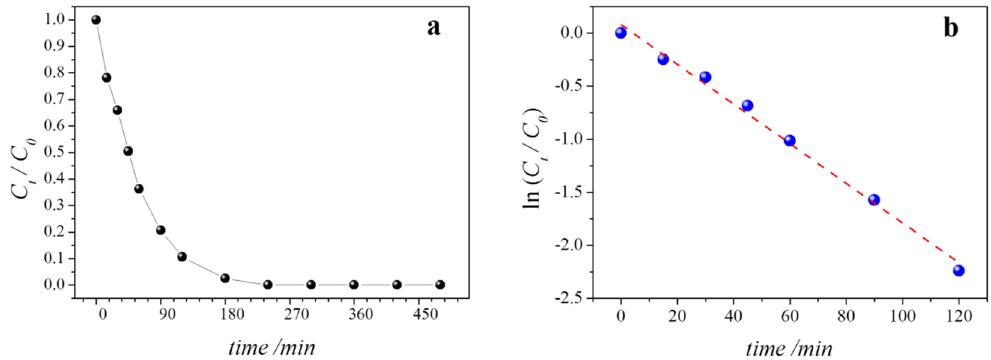
Figure 5. ( a ) Relative concentration decay of 4-nitrophenol determination by HPLC during degradation experiments. ( b ) Linear region used for the calculations of rate constant from pseudo-first order reaction.